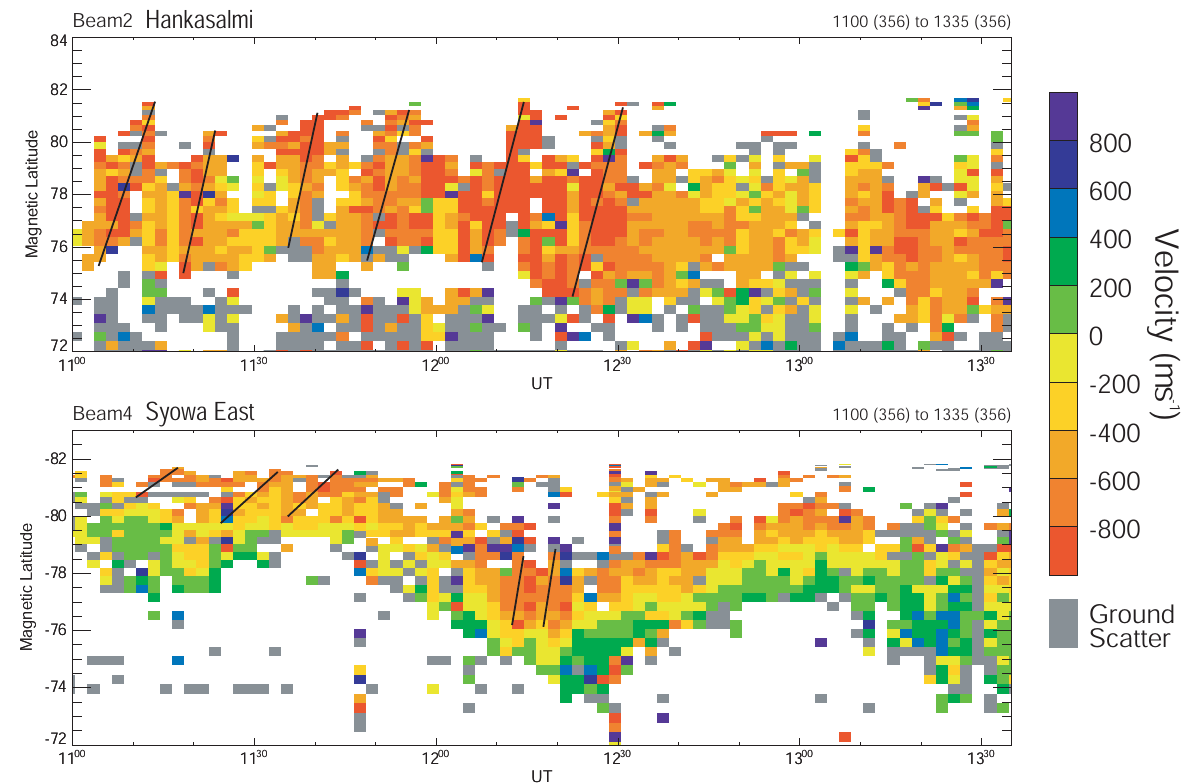
Fig. 9. L-o-s velocities from the Hankasalmi (beam 2) and Syowa East (beam 4) radars from 11:00 to 13:35 UT during interval A. Overplotted black lines highlight some of the